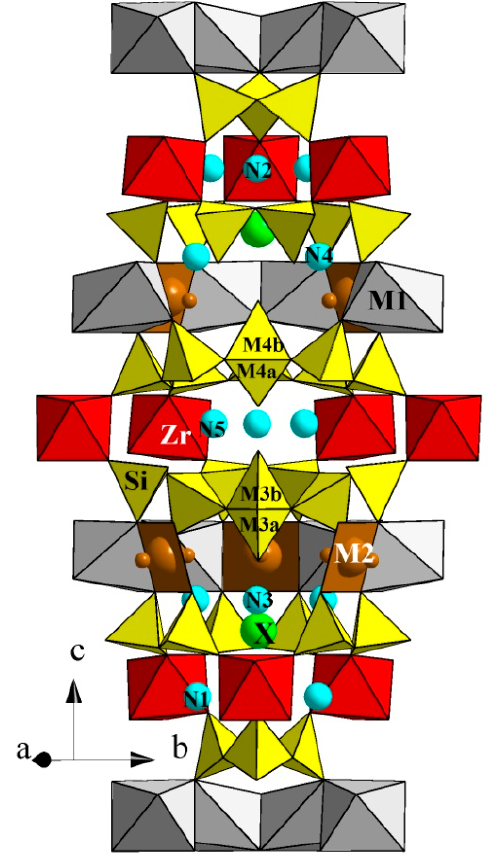
Figure 1. The crystal structure of eudialyte-group minerals (a simplified sketch).